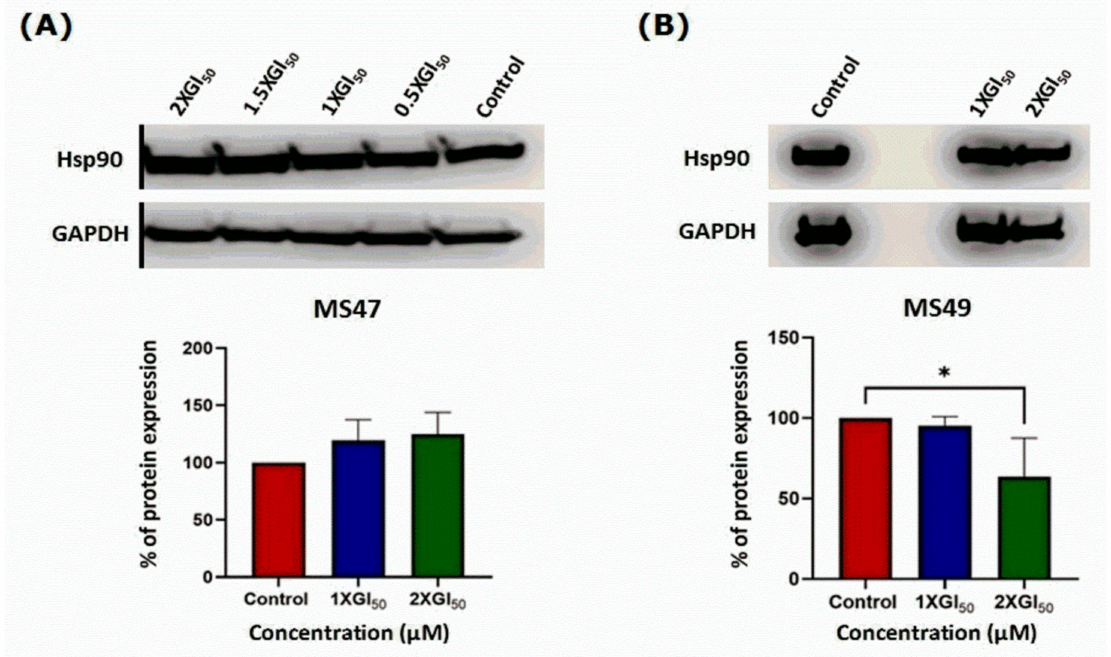
Figure 8. Hsp90 protein expression in human melanoma MDA-MB-435 cells; vehicle control and treated with (1 × GI 50 and 2 × GI 50 ) of ( A ) ligand MS47 and ( B ) ligand MS49 for 72 h after incubation. Data are means ± SEM of three separate experiments (ANOVA statistical analysis followed by Tukey’s test; * p < 0.05). Blot images are splices to present the intended groups. The original image files for the blots are found in the Supplementary Materials (Figure